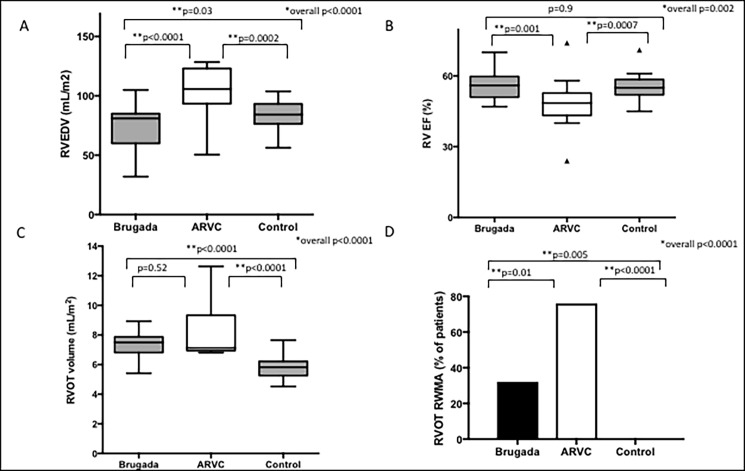
Morphology comparison between BrS, ARVC and control cohort.Box and whiskers plot of (A) RVEDV (B) RVEF (C) RVOT volume; column graph of (D) RVOT RWMA in BrS compared with control and ARVC cohorts. Box and whiskers values are median (IQR). Whiskers include values within 1.5 IQR of the nearest quartile. Boxes are based on Tukey’s Hinges. *overall comparisons RVEDV/RVEF/RVOT volume one-way ANOVA; RVOT RWMA Fishers-exact test. **column comparisons Mann-Whitney test.